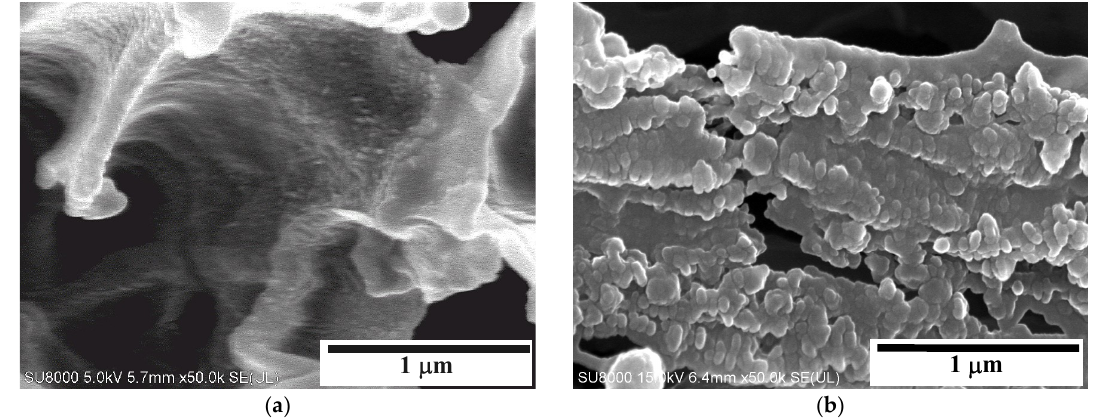
Figure 5. SEM image of the PP-T membrane cross-section. Magnification 50,000×. ( a ) surface inside the pore; ( b ) shish-kebab crystal structures.